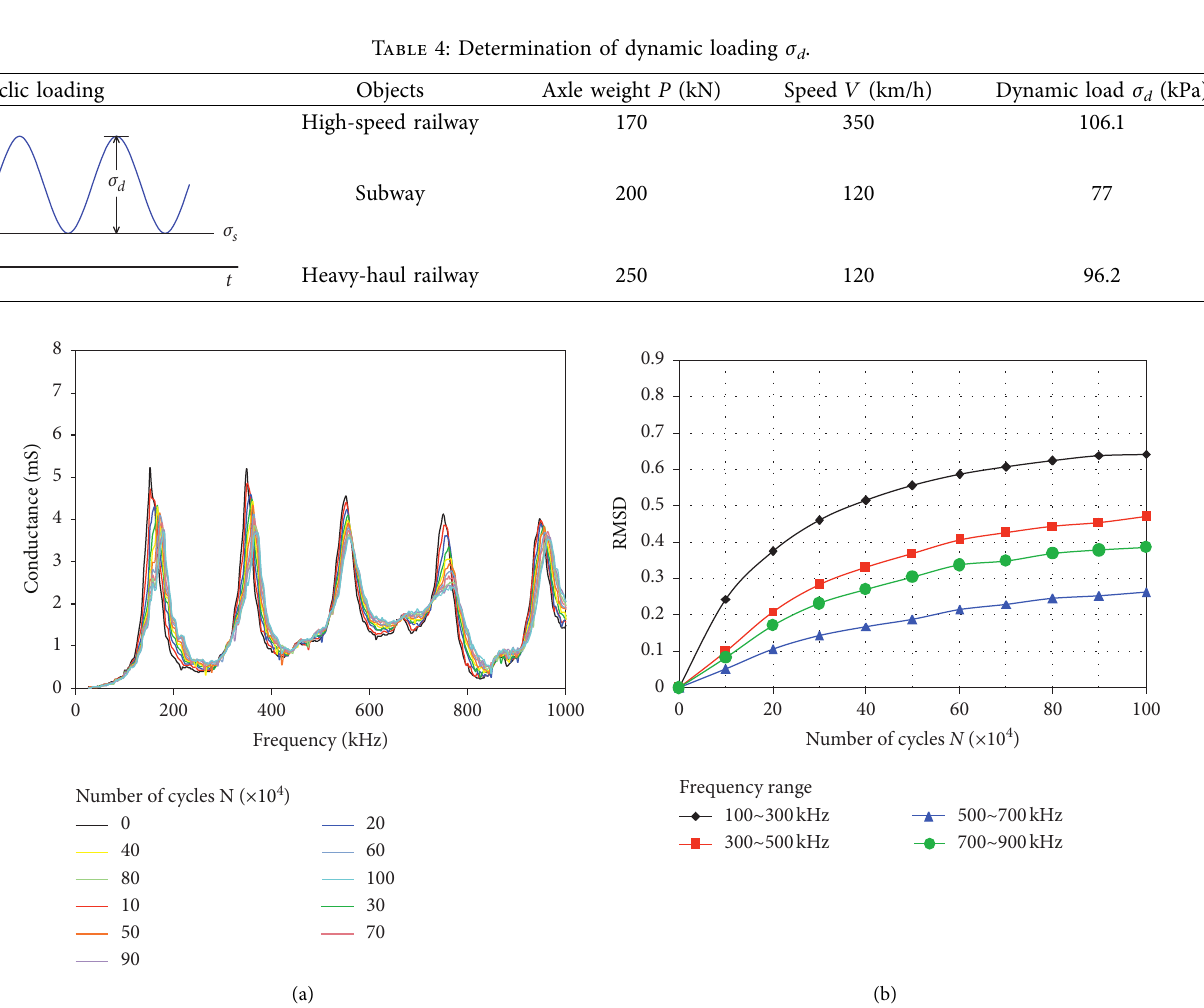
Figure 3: The influence of frequency range selection on the damage index: (a) conductance signatures of specimen I15-1; (b) RMSD values calculated from the signatures subjected to a certain resonant frequency range.